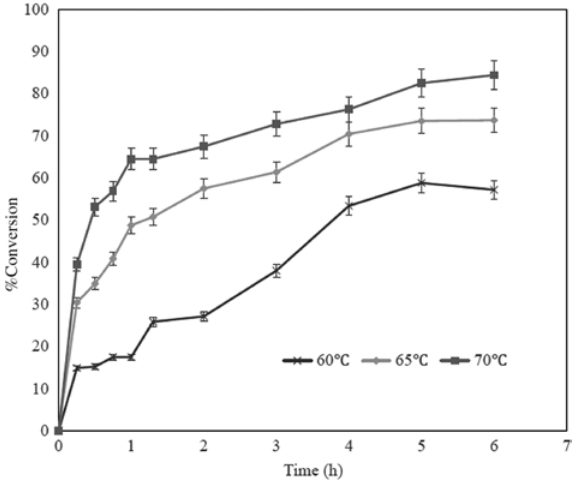
Figure 3: Influence of amount of catalyst Fermase on reaction con- version at stearic acid to PEG 600 ratio 1:4, temperature 70 ° C, speed of agitation 200 rpm, and molecular sieves